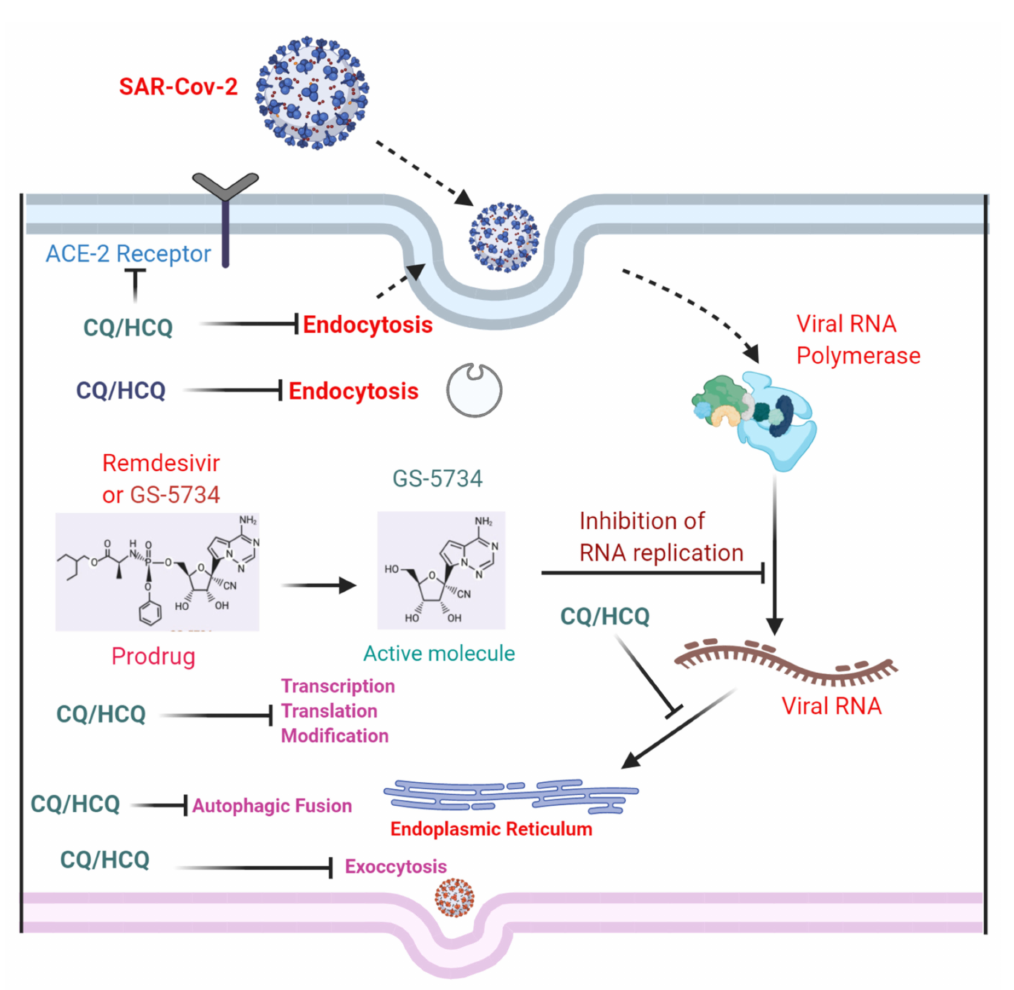
Figure 7. Effects of chloroquine and hydroxychloroquine against COVID-19. A simple diagram show- ing the protective mechanisms of chloroquine and hydroxychloroquine against COVID-19-associated complications. ACE: angiotensin-converting enzyme; CQ: chloroquine; HCQ: hydroxychloroquine; RNA: ribonucleic